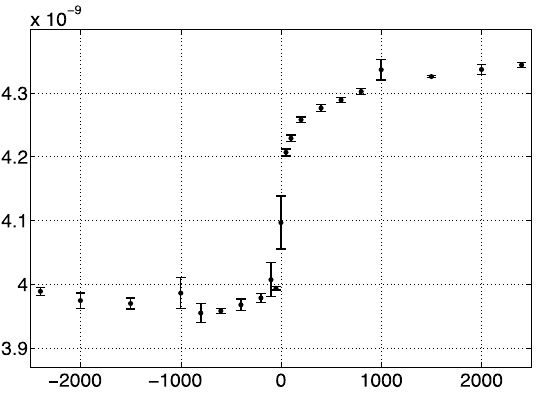
Figure 10. Transversal, longitudinal and radial components of the FC prototype electric field as a function of the FC longitudinal size, obtained using the COMSOL software (COMSOL, Brescia, Italy).